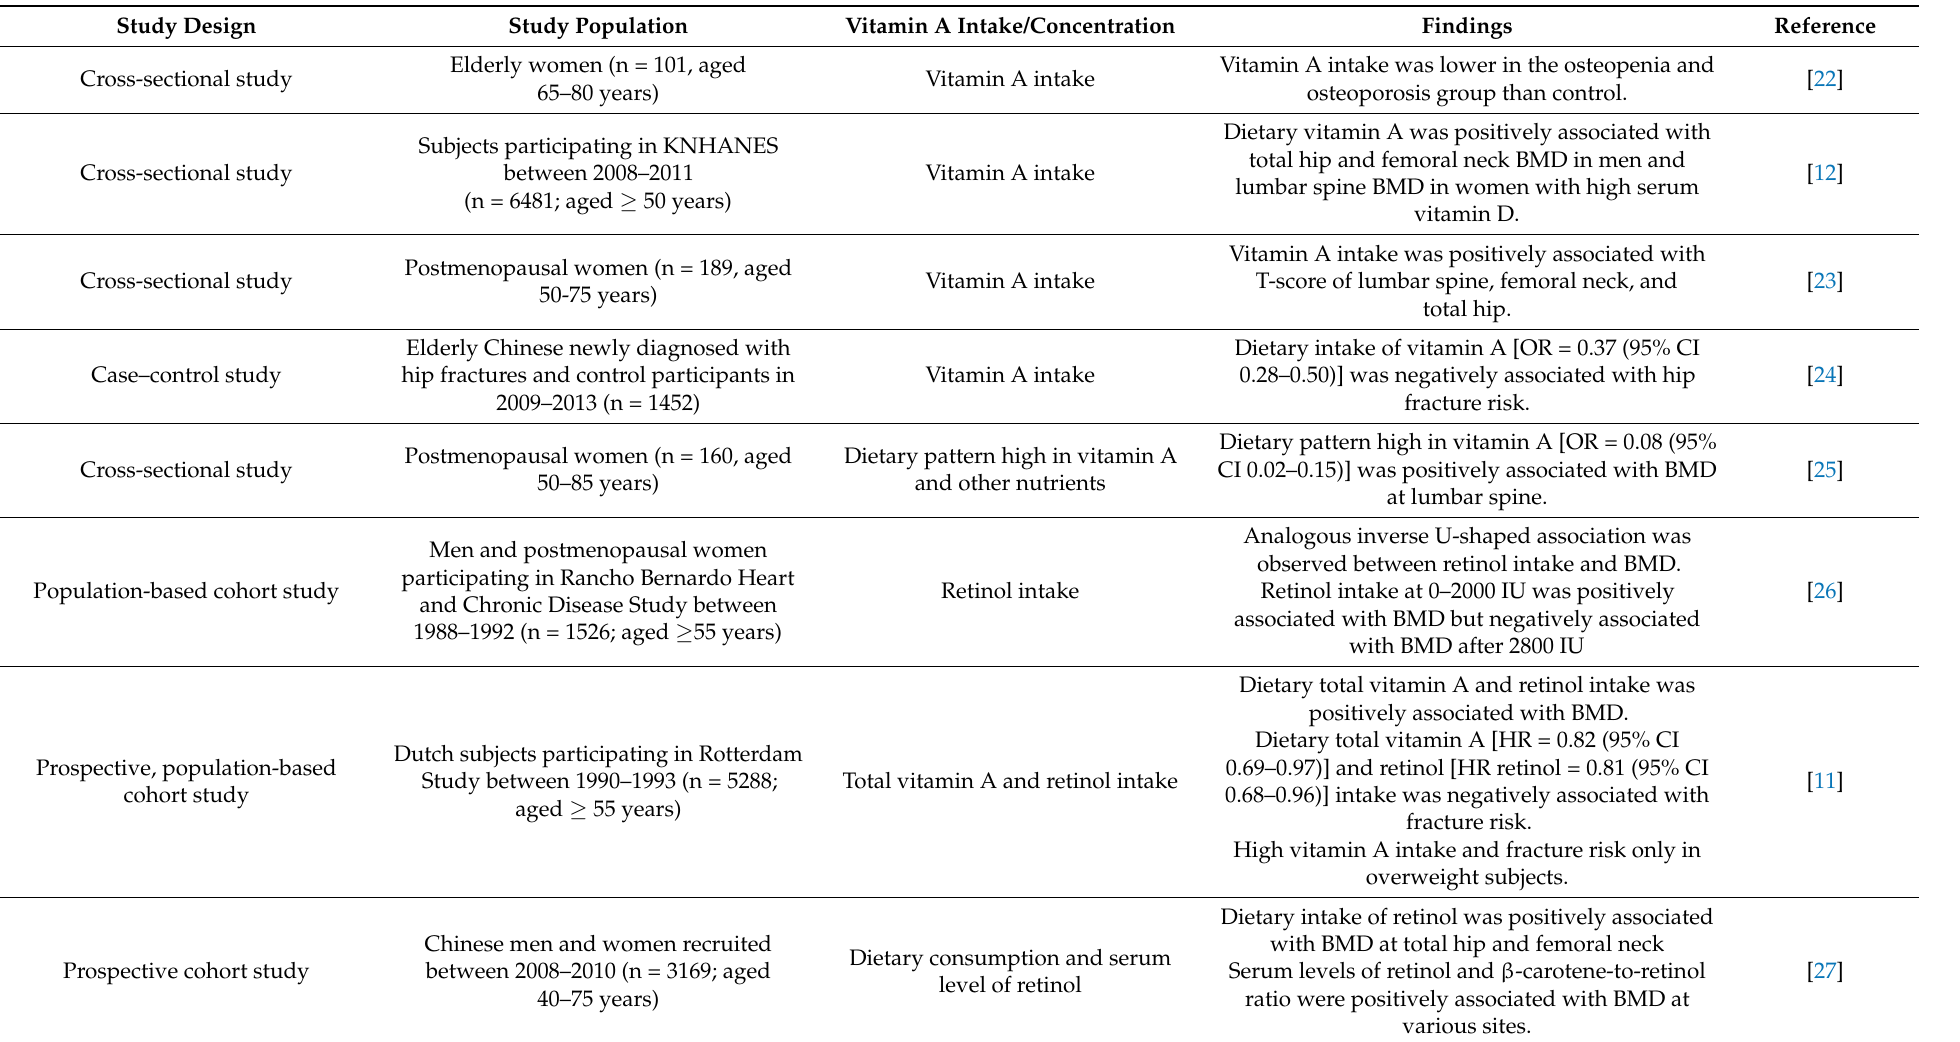
Table 2. Summary on the effects of vitamin A and provitamin A on bone health in